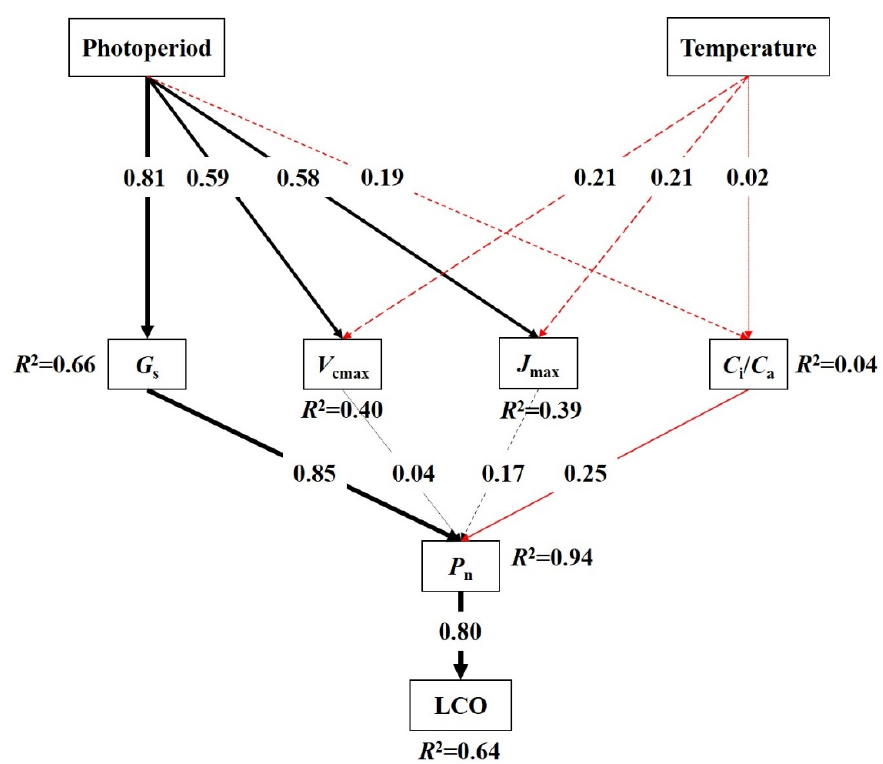
Figure 5. Structural equation model (SEM) analysis of the effects of photoperiod and temperature on LCO. Square boxes indicate variables in the model. Results of model fitting: χ 2 = 4.00, p = 0.95, df = 10, and n = 23. Black and red arrows denote the positive and negative correlation pathways, respectively. Arrow width indicates relationship strength. Solid and dashed lines represent significant ( p < 0.05) and nonsignificant ( p > 0.05) pathways, respectively. The number associated with the arrow represents standardized path coefficients, and R 2 values indicate the proportion of the variation explained for each dependent variable in the model.